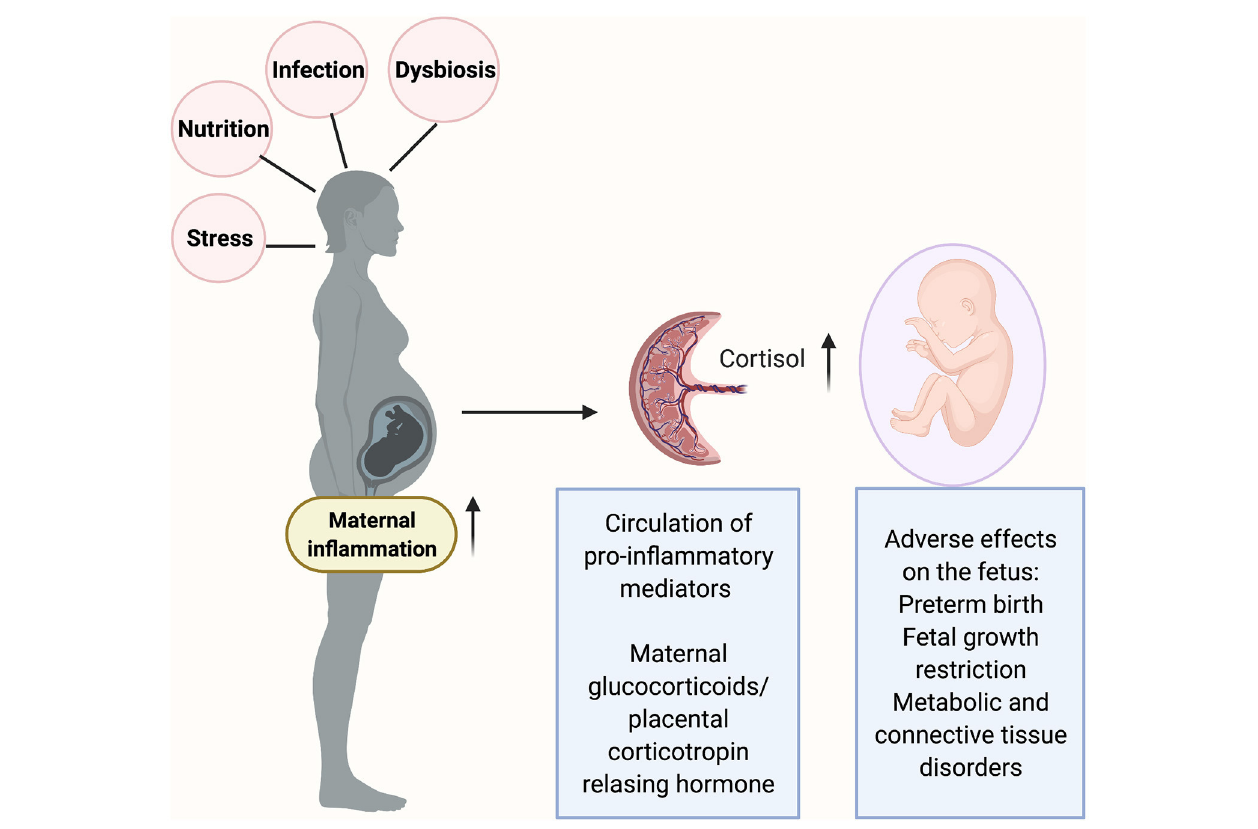
FIGURE 2 | Inflammatory triggers in pregnancy such as maternal infection, stress and malnutrition can cause a release of pro-inflammatory mediators at the maternal-fetal interface (placenta). The placenta produces corticotropin releasing hormone (CRH) in response to stress. Excessive inflammation can result in fetal exposure to the glucocorticoids which in turn can reprogram the fetal hypothalamic-pituitary-adrenal (HPA) axis and alter the fetal developmental processes as well the immune system development. Figure created using the BioRender software.